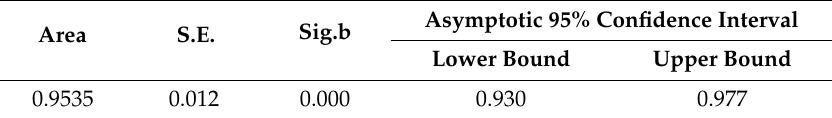
Table 6. Quality of model—AUC.